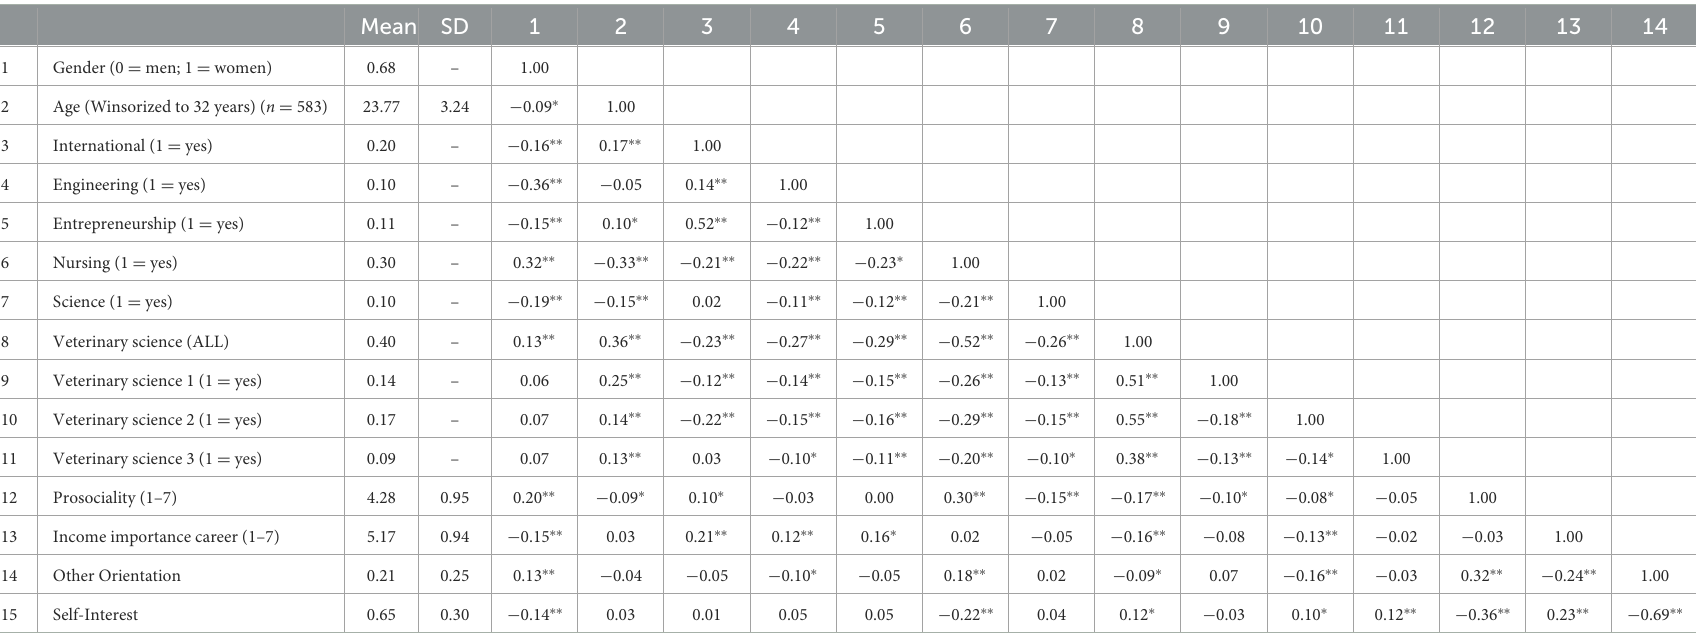
TABLE 3 Means, standard deviations and bivariate correlations (Spearman Rho) of demographic and self-report variables and conjoint relative importance scores ( n =